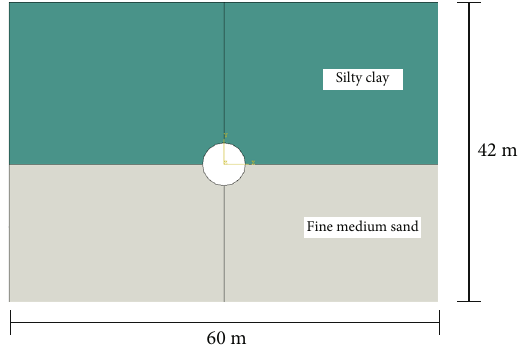
Figure 11: Crack propagation under the disturbance of